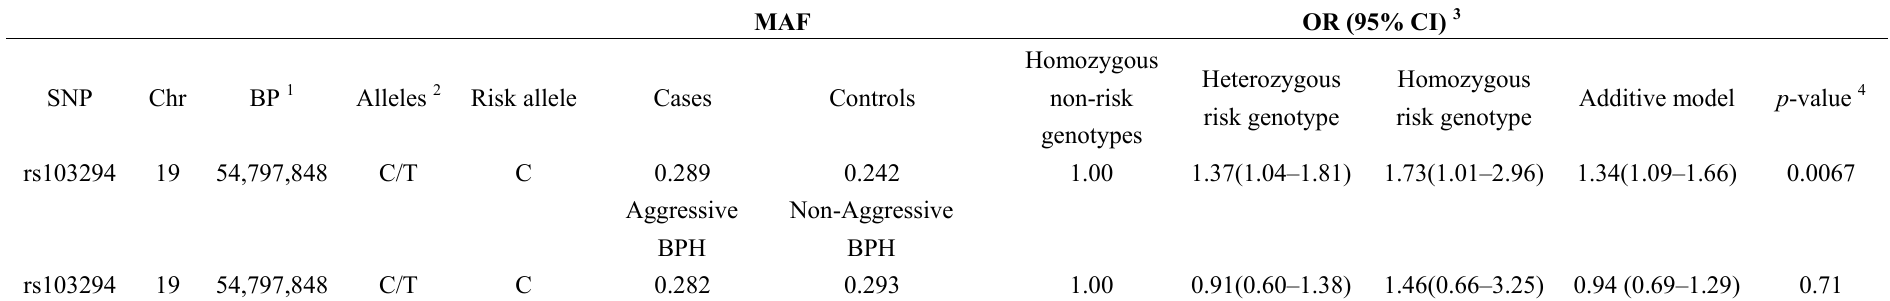
Table 2. Association results for rs103294 on LILRA3 and benign prostatic hyperplasia (BPH)/Aggressiveness